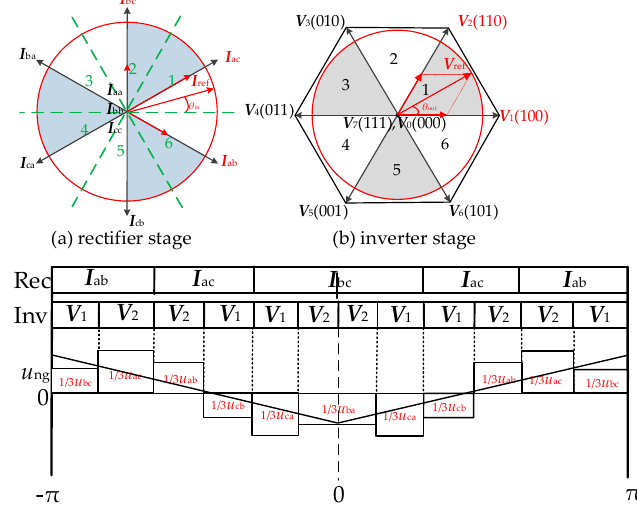
Figure 8. Modulation principle and vector distribution of method 4.